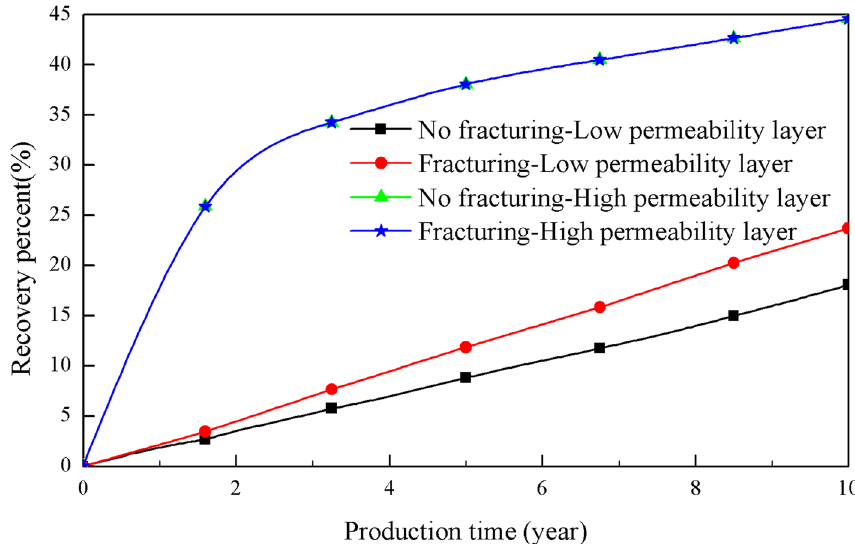
Fig. 5 Oil recovery percent of different